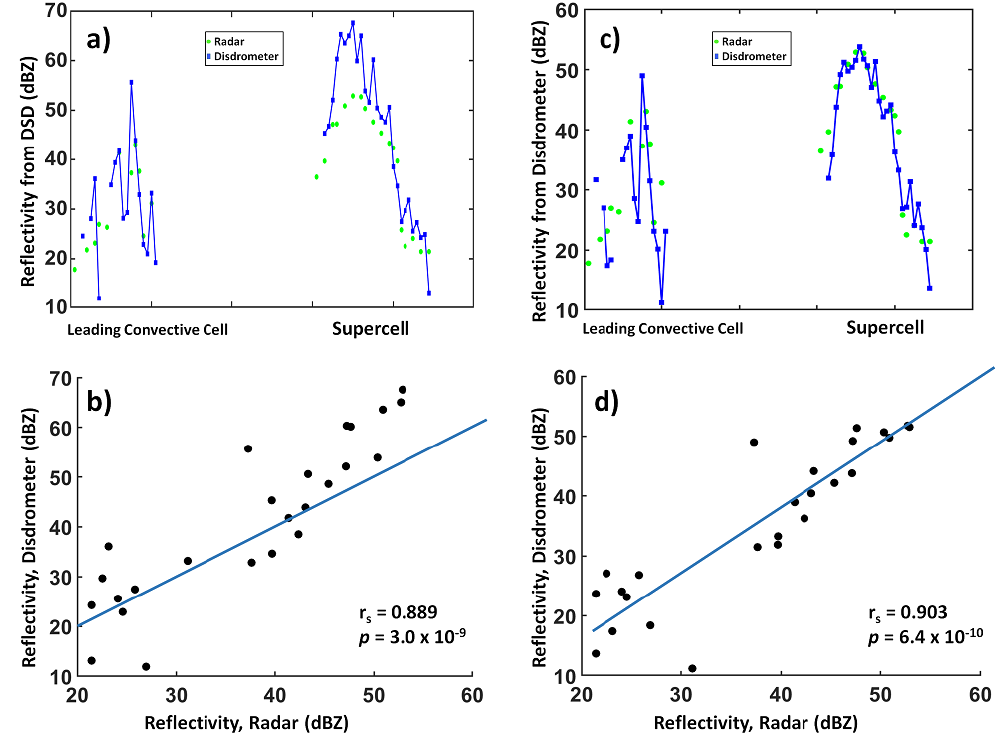
Figure 3. Reflectivity (Z HH ) comparisons between radar and disdrometer datasets. ( a ) and ( b ) contain radar estimates of Z HH compared to values calculated from the disdrometer dataset using Equation (6), while ( c ) and ( d ) are a comparison between radar estimates of Z HH and raw disdrometer Z HH estimates (Equation (8)). Green dots and blue rectangles in ( a ) and ( c ), respectively, are radar and disdrometer estimates, and blue lines are broken when no precipitation was recorded by the disdrometer. In ( b ) and ( d ), the blue 1:1 line indicates where points would fall given exact correspondence between Z HH estimates. Spearman’s correlation (r s ) is indicated along with its p -value. Atmosphere 2020 , 11 , x FOR PEER REVIEW Differential reflectivity estimated by KOAX was compared with Z DR calculated from the DSD using Equation (2) (Figure 4). This comparison was reasonably robust ( r s 2 = 0.225; Figure 4b), though the comparison between radar- and disdrometer-estimated Z DR was more robust for the supercell ( r s = 0.684) than for the leading convective cell ( r s = − 0.086).